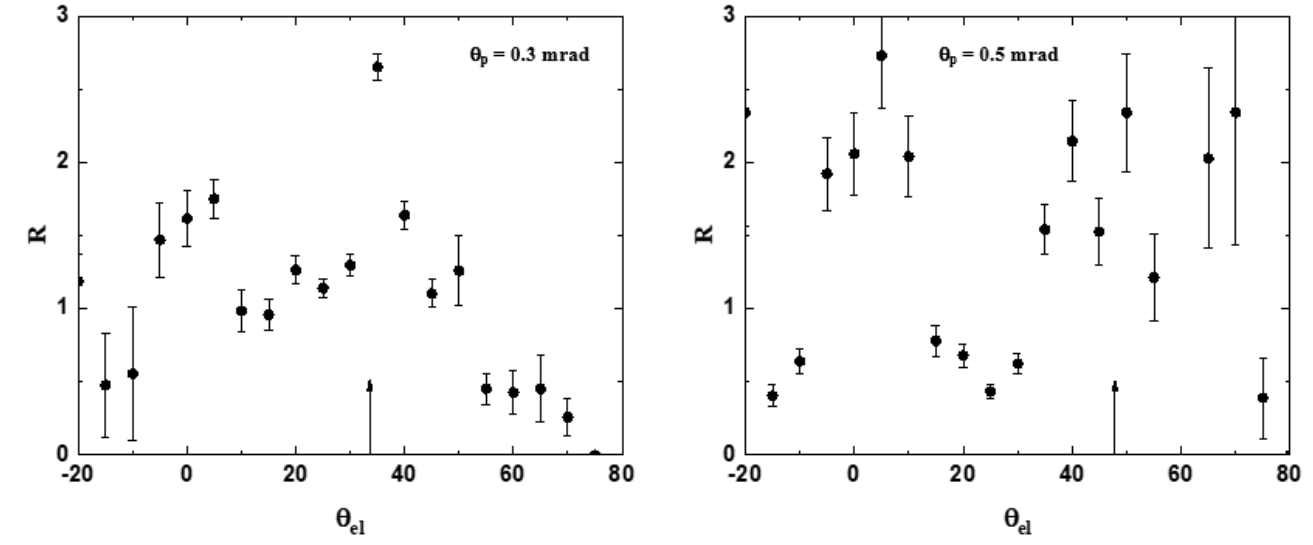
Figure 3. Ratios between the coherent and incoherent FDCS from Figure 2.